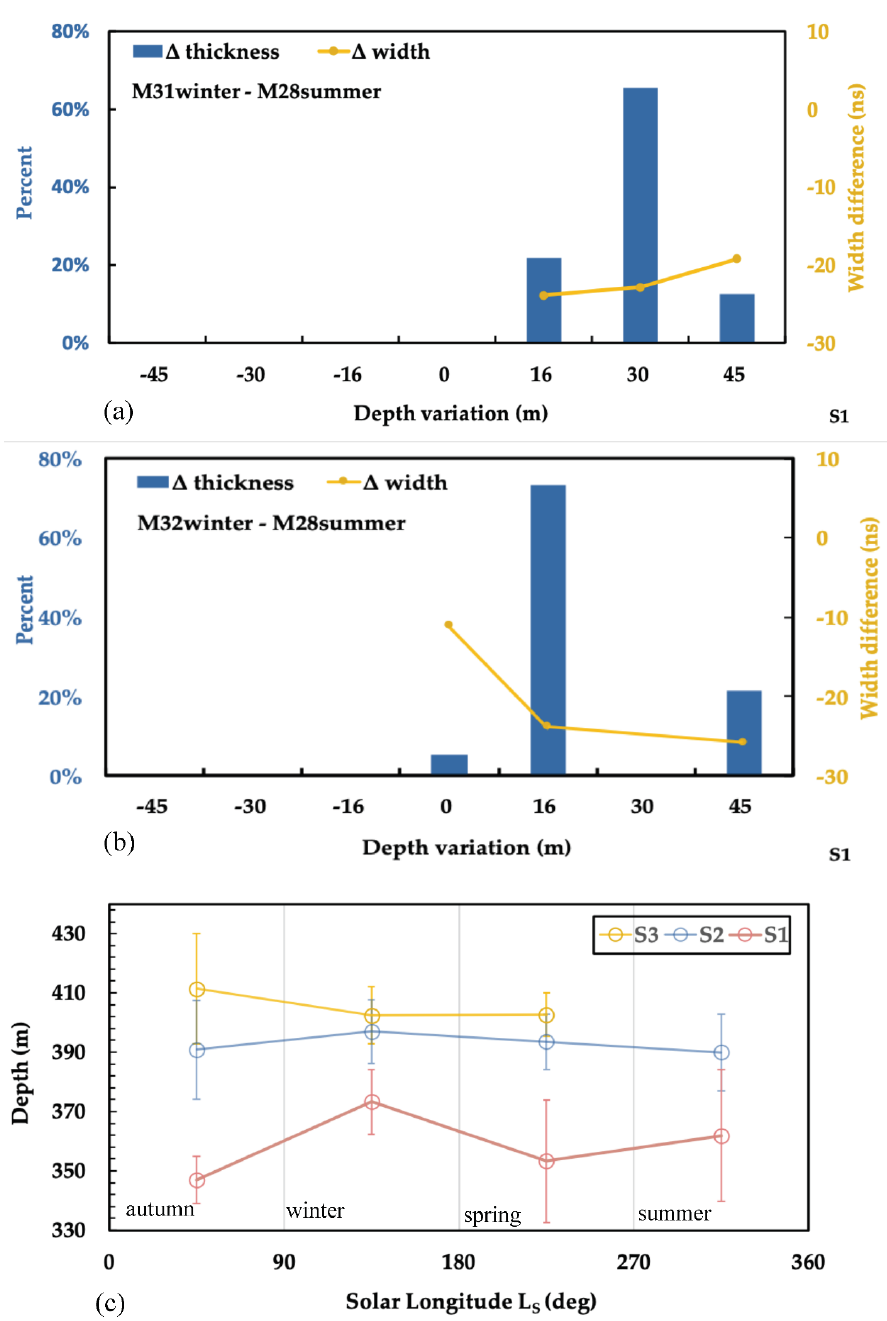
Figure 8. Seasonable variations of AA 3c thickness and the pulse width of SHARAD surface echo. ( a , b ) the histogram of the seasonal variation of AA 3c thickness and pulse width on surface echo in S1. The horizontal axis presents the depth change of AA 3c of each two subsatellite points, which distance is less than 3 km. The vertical axis on the left shows the statistical percentage, and the vertical axis on the right shows the width difference about FWHM, or the width of winter subtracted from that in summer. M28summer: Martian year 28 in summer; M31winter: Martian year 31 in winter; M32winter: Martian year 32 in winter. ( c ) the average thickness of AA 3c in different seasons. S1, S2 and S3 regions are indicated by the colors blue, red, and yellow, respectively. The horizontal axis is the solar longitude, and the vertical axis is the depth of AA 3c . Please note that data points with FWHM of the surface and subsurface echoes >150 ns are not included. For example, the vacancy of the summer data in S3, or the solar longitude is 270–360 degrees, is because no data meet the standard for the